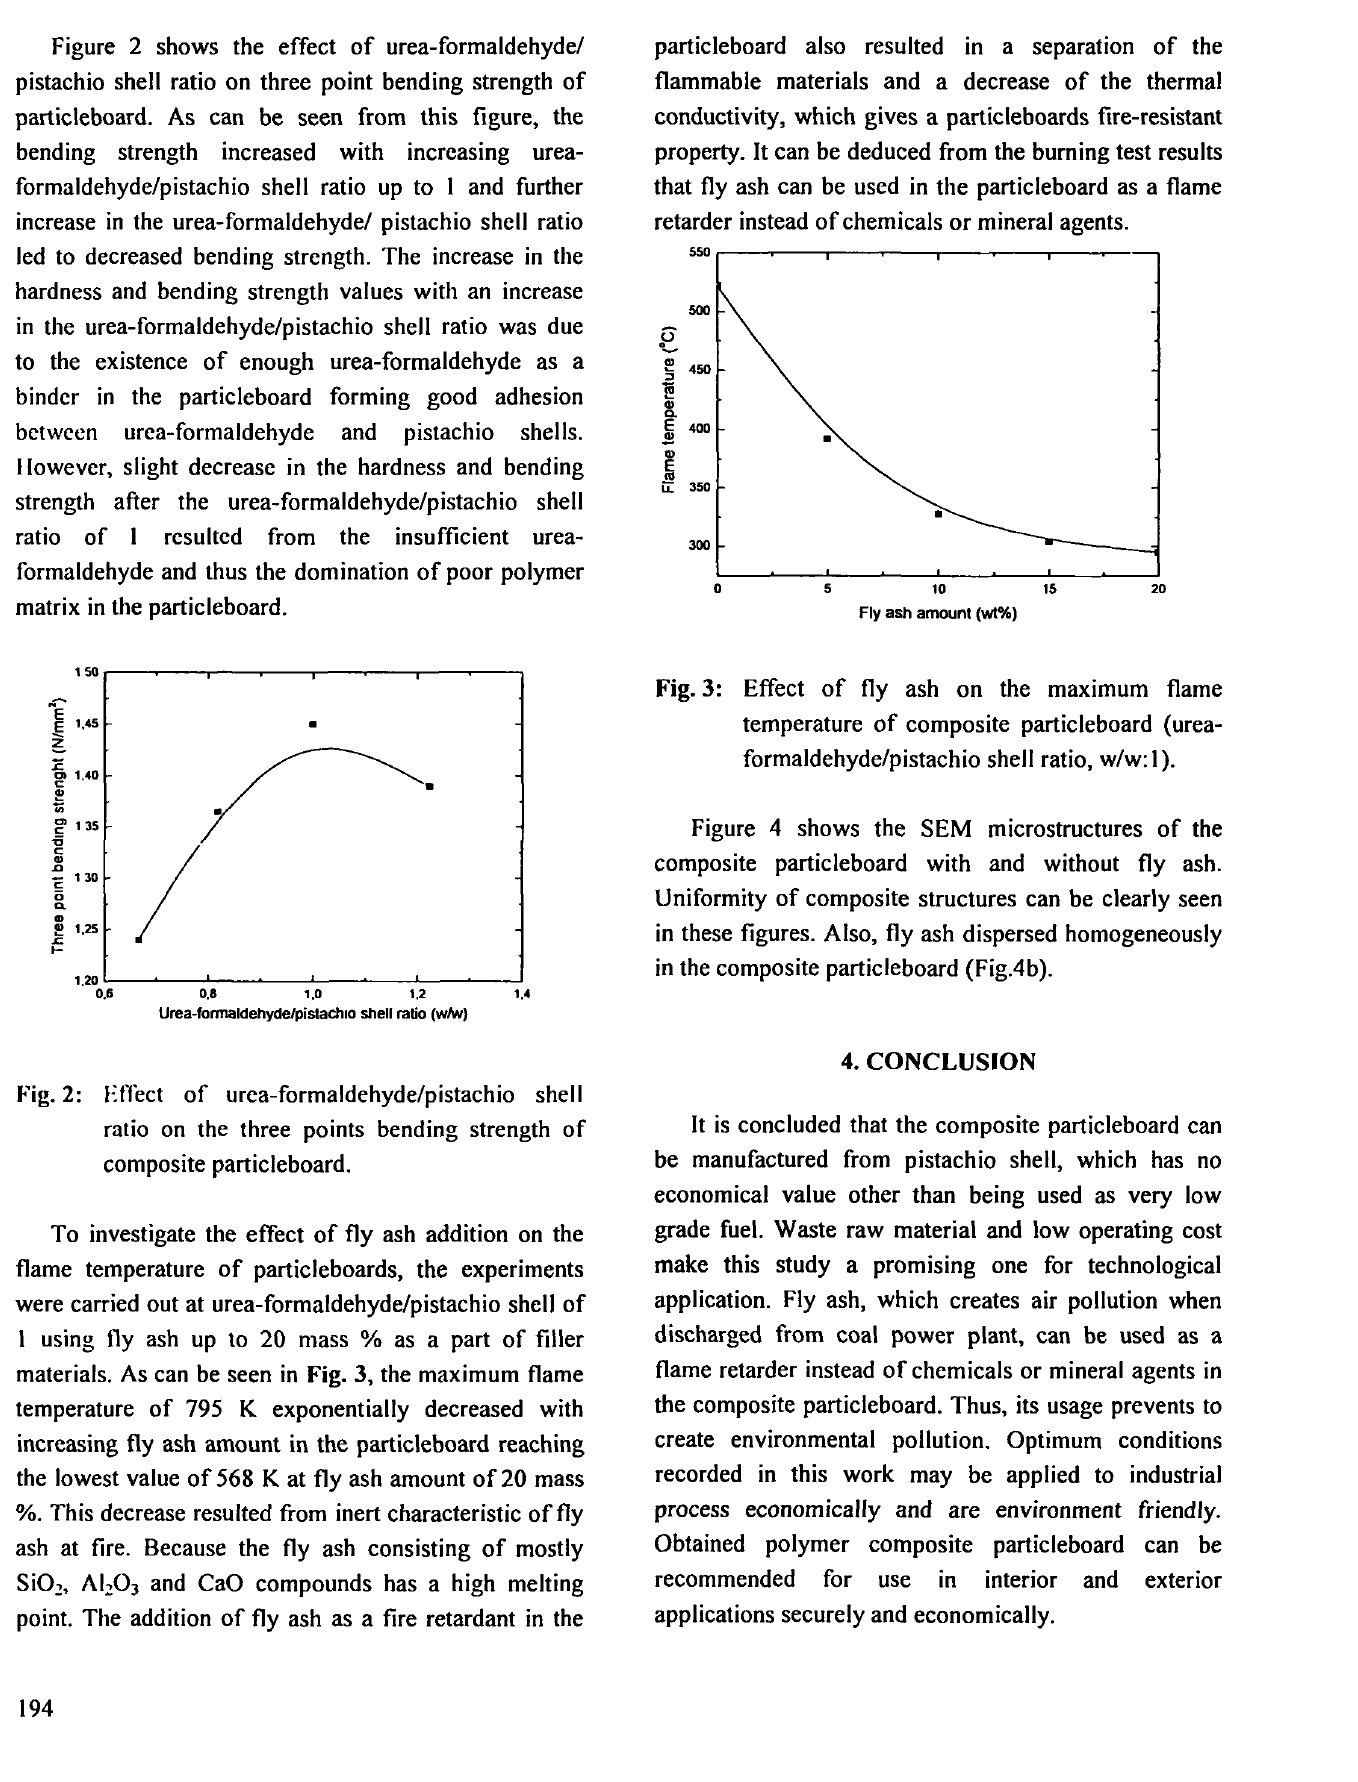
Fig. 2: Κ fleet of urea-formaldehyde/pistachio shell ratio on the three points bending strength of composite particleboard.